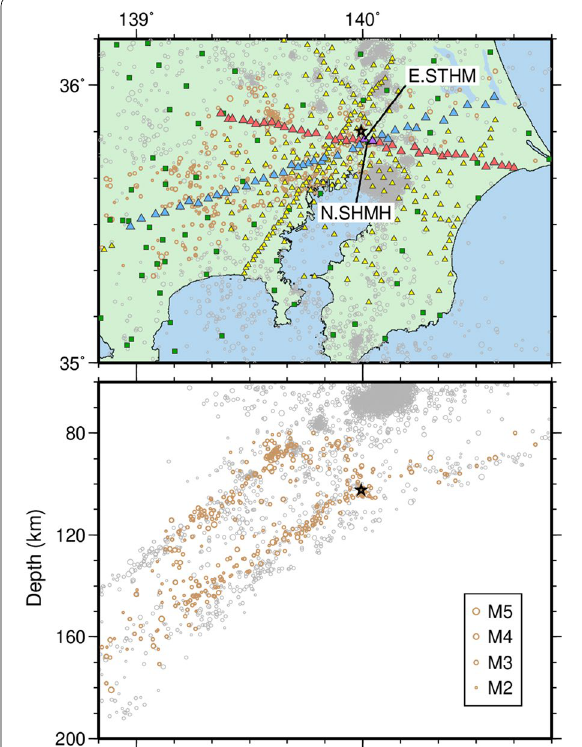
Fig. 1 Seismic network of MeSO-net (triangles) and Hi-net (squares) stations. Blue, red, and purple triangles represent the stations used for the ENE–WSW profile, ESE–WNW profile, and both profiles, respectively. Circles represent the hypocenters of M ≥ 2 earthquakes at depths greater than 80 km from May 16, 2008, to June 30, 2021, from the unified catalog of the JMA; brown indicates earthquakes used in this study. Stars indicate the hypocenters of the earthquakes used in Fig.